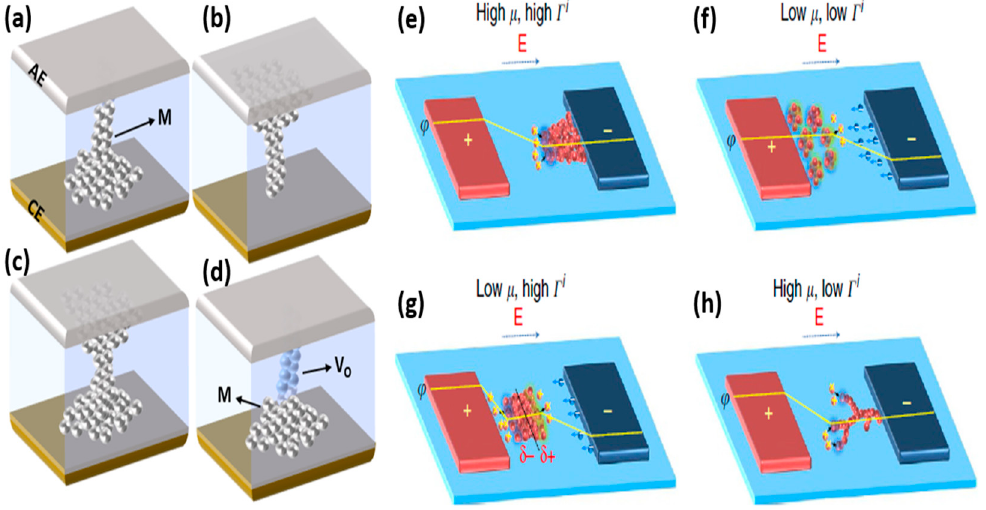
Figure 6. Formation of the CFs in CBRAMs with different shapes and compositions as ( a ) inverted conical shape, ( b ) conical shape, ( c ) hourglass shape and ( d ) hybrid CF composed of metal atoms and oxygen vacancies. Qualitative model showing CF growth dynamics governed by kinetic parameters such ad ion mobility ( μ ) and redox rates ( Γ i ). When ( e ) both μ and Γ i are high, ( f ) both μ and Γ i are low, ( g ) μ is low but Γ i is high, and ( h ) μ is high but Γ i is low. Reprinted from Ref. [34].